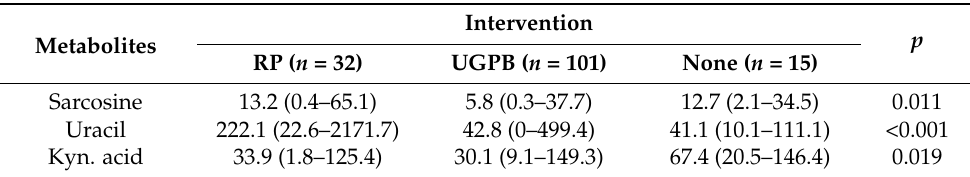
Table 6. Endogenous metabolites in urine according to intervention—group A + B + C. Values are presented as medians/ranges in µ